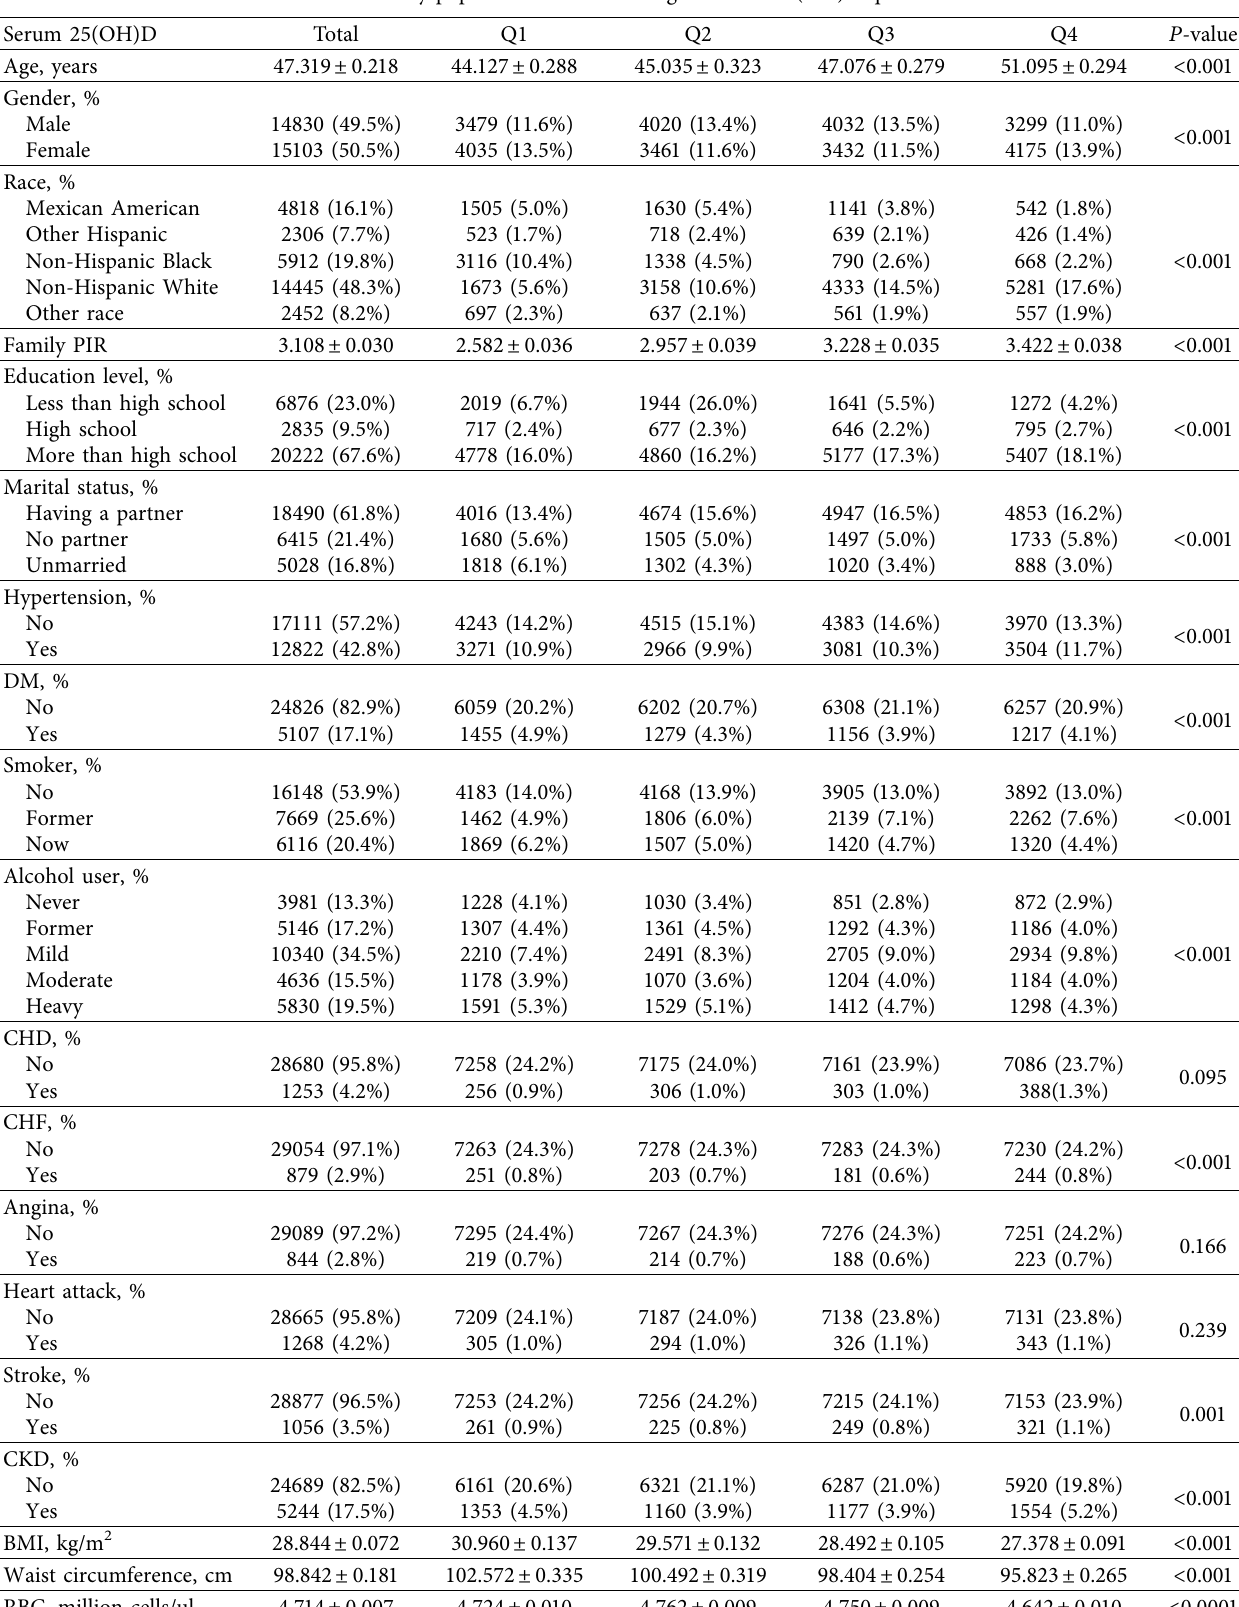
Table 1: Study population data according to serum 25(OH)D